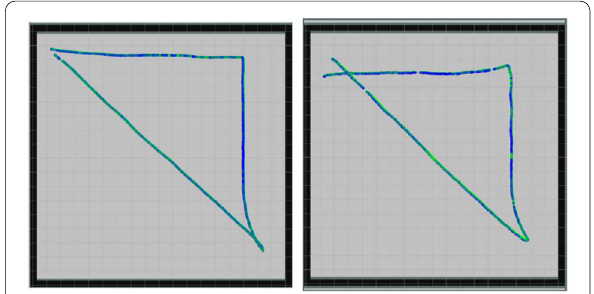
Fig. 13 Measured trajectories using the EKF. Green lines indicate the trajectories obtained using the robotic total station, and purple lines indicate the trajectories obtained using the GNSS and wheel odometry. The left figure is result when using RTK-GPS and right figure is result when using QZSS